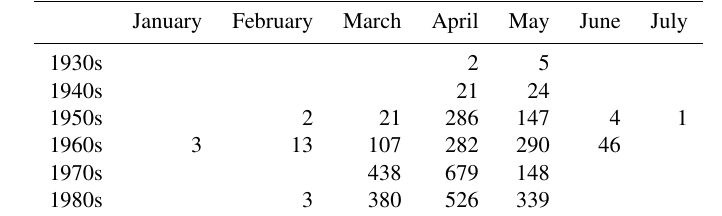
Table 1. The number of landings of Sever expeditions by decade and month.